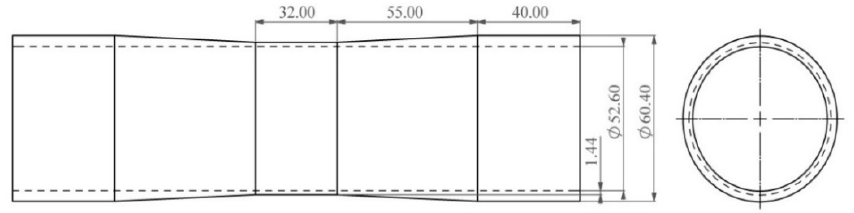
Figure 1. Pipe specimen dimension (mm).